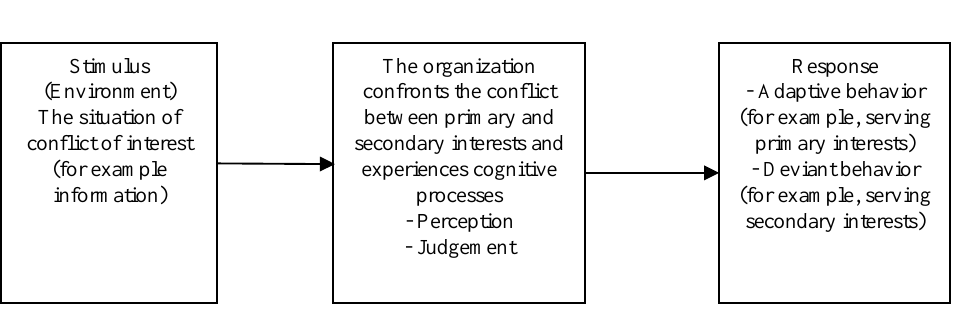
Figure 3. Conceptual structure (stimulus-organism-response): a combination of social cognition theory and operational power model (Holt et al.,